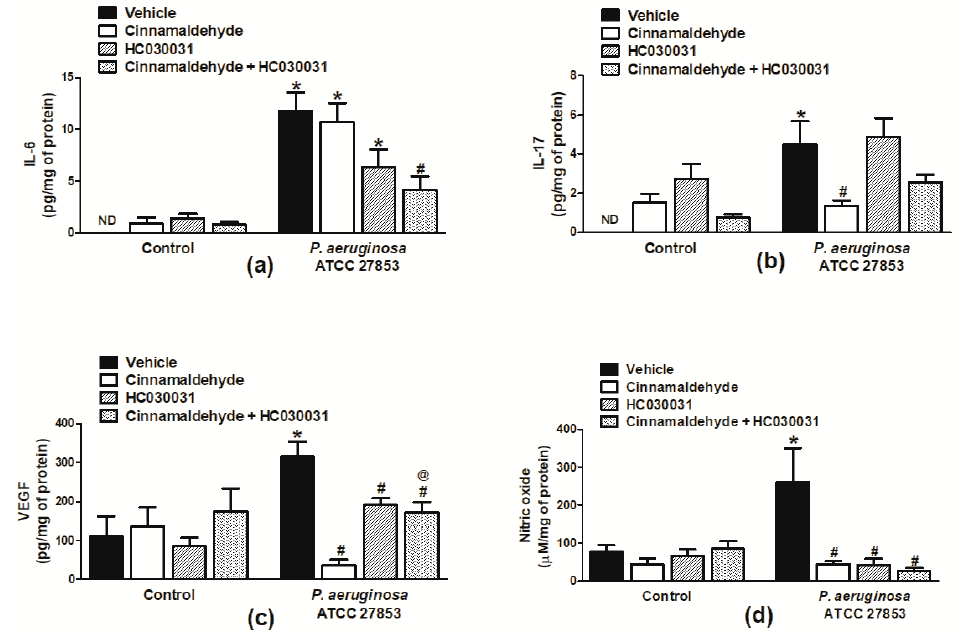
Figure 5. Inflammatory mediator release in cinnamaldehyde-treated mouse skin wounds. The levels of ( a ) IL-6, ( b ) IL-17, ( c ) VEGF and ( d ) NO in skin wounds of animals infected or not with P. aeruginosa ATCC 27853. Cinnamaldehyde (0.5 mg/mL; 30 μ L, n = 6) or 2% DMSO in sterile saline (30 μ L, n = 6) were topically